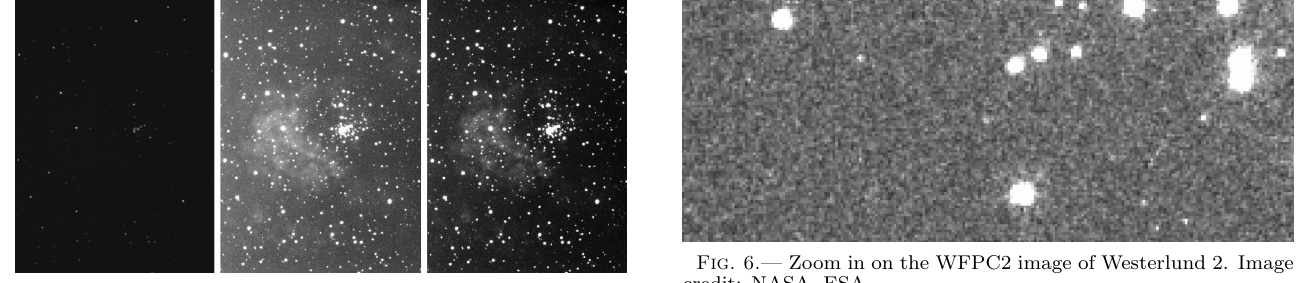
Fig. 4.— Part of the Westlund 2 image taken through an R (red) filter in April 2017 with the 2 m Faulkes Telescope operated by Las Cumbres Observatory at Siding Spring in Australia with different scaling. Left: Linear scaling from 0 to 65536. Center: Linear scaling from 4572 to 6002. Right: Square scaling from 4572 to 6002